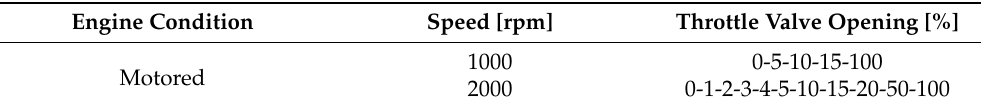
Table 2. Operative Table 2. Operative conditions.